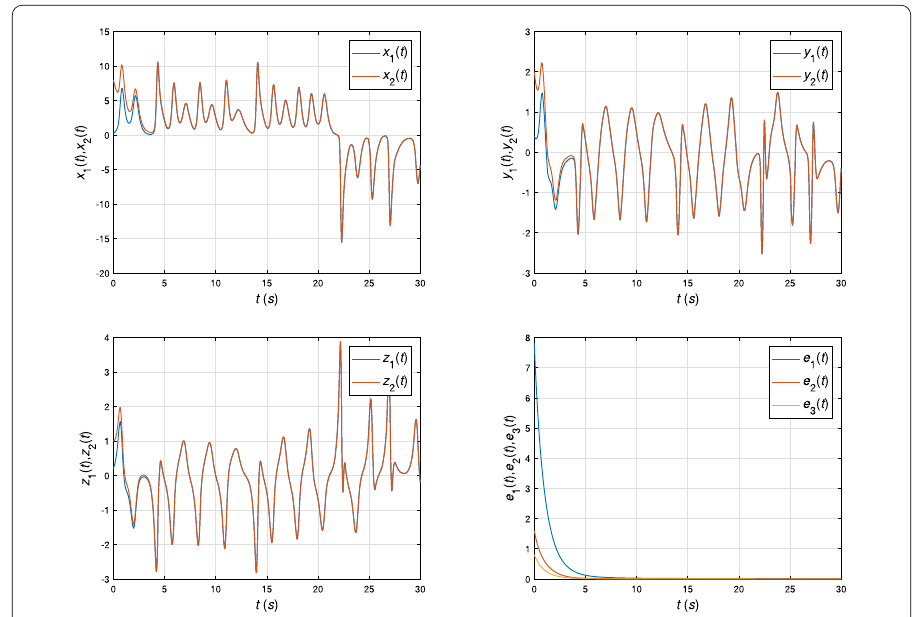
Figure 9 Synchronization results between two nonidentical fractional-order systems (37) and (38) for α 1 = α 2 = α 3 =